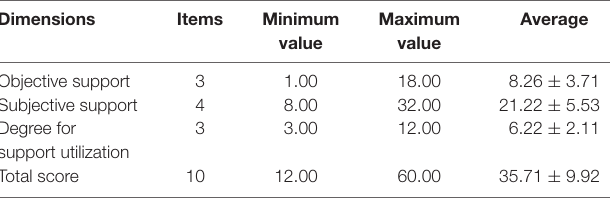
TABLE 4 | Total score of social support and score of each dimension in patients with complicated hepatolithiasis ( n =